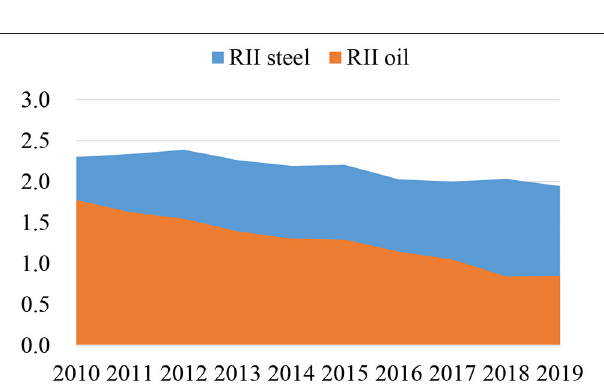
FIGURE 3 | China’s automobile Resource Input Intensity (RII) in